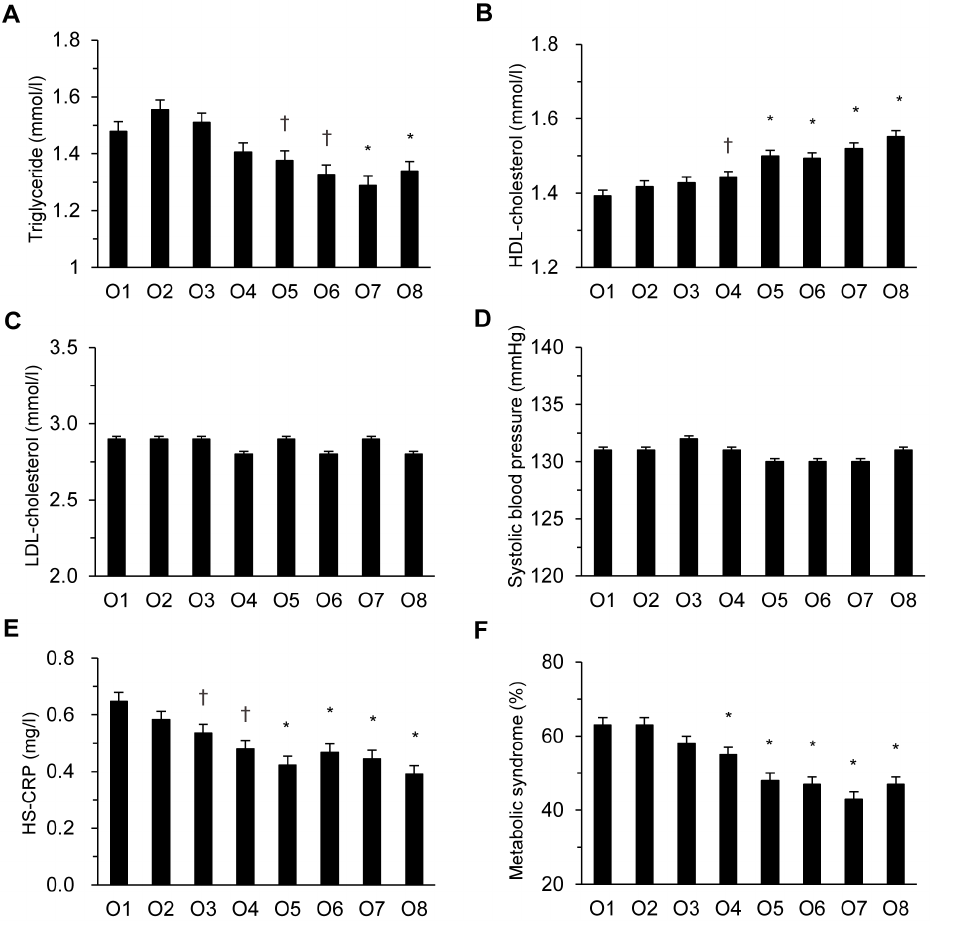
Figure 2. Changes in cardiovascular risk factors according to the octile of total leisure-time physical activity in Japanese type 2 diabetes patients. Age- and sex-adjusted triglyceride (A), high density lipoprotein (HDL) cholesterol (B), low density lipoprotein (LDL) cholesterol (C), systolic blood pressure (D), high sensitivity C-reactive protein (HS-CRP) (E), and prevalence of metabolic syndrome (F) in the octile of T-LTPA in 4,870 Japanese type 2 diabetic patients. + p , 0.05, *p , 0.01 vs. the lowest